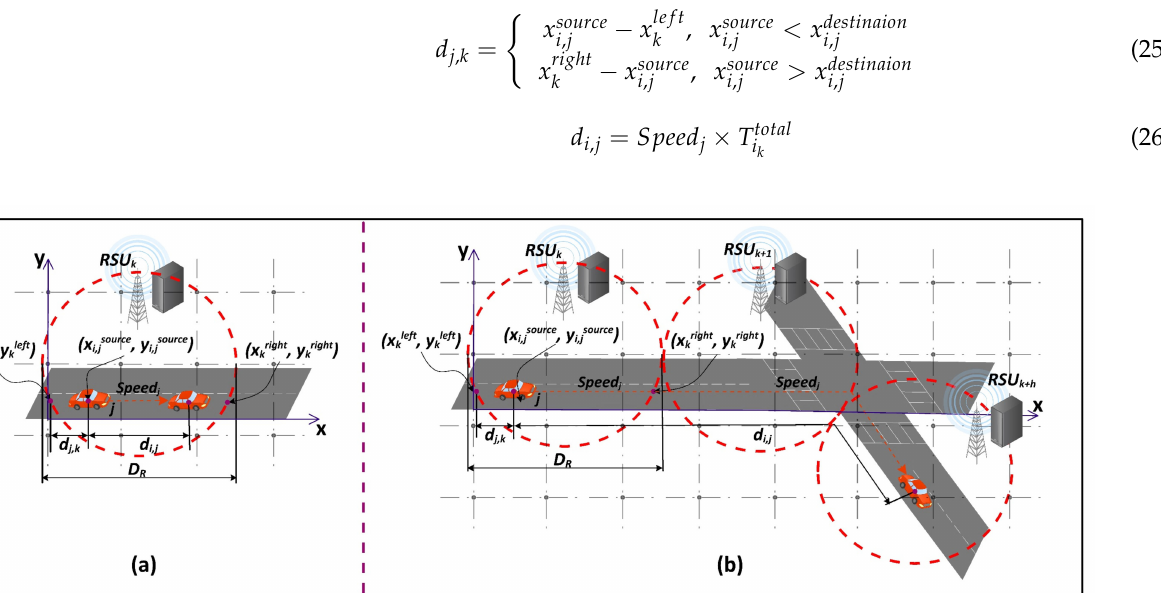
Figure 3. ( a ) Request-response delivery when the vehicle is in the range of the RSU to which the request was submitted. ( b ) Request-response delivery when the vehicle is not in the range of the RSU to which the request was